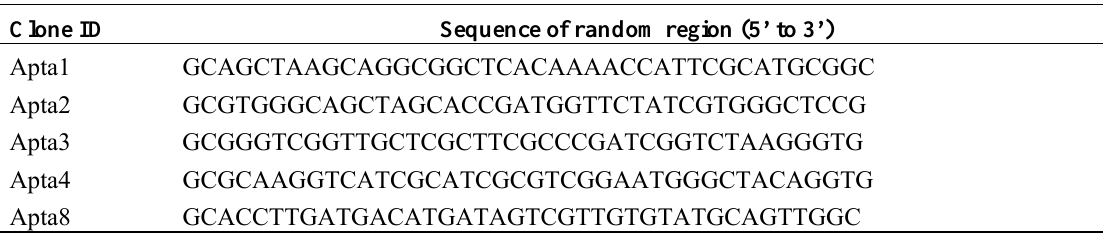
Table 1. Sequences of the clones remaining after five rounds of selection using CE- SELEX. Only the random region (40 nucleotides) is